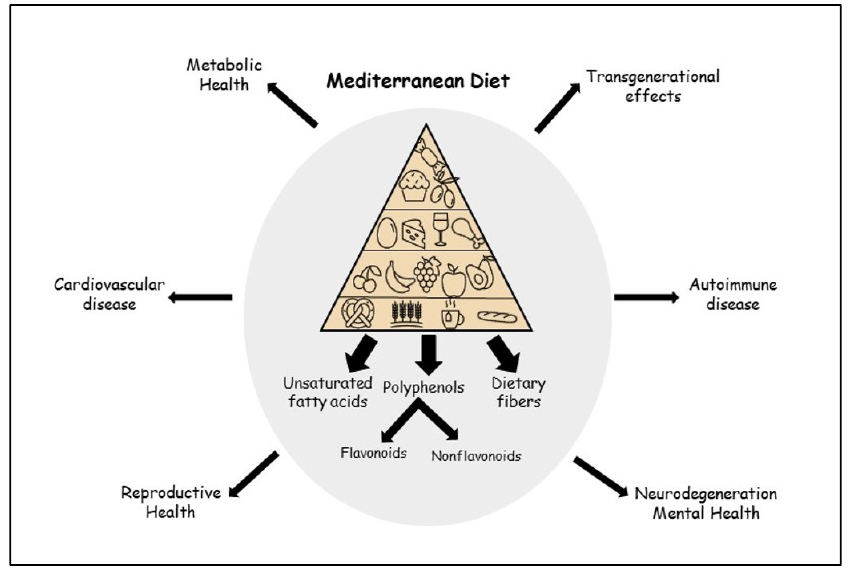
Figure 1. Beneficial effects of the Mediterranean diet.